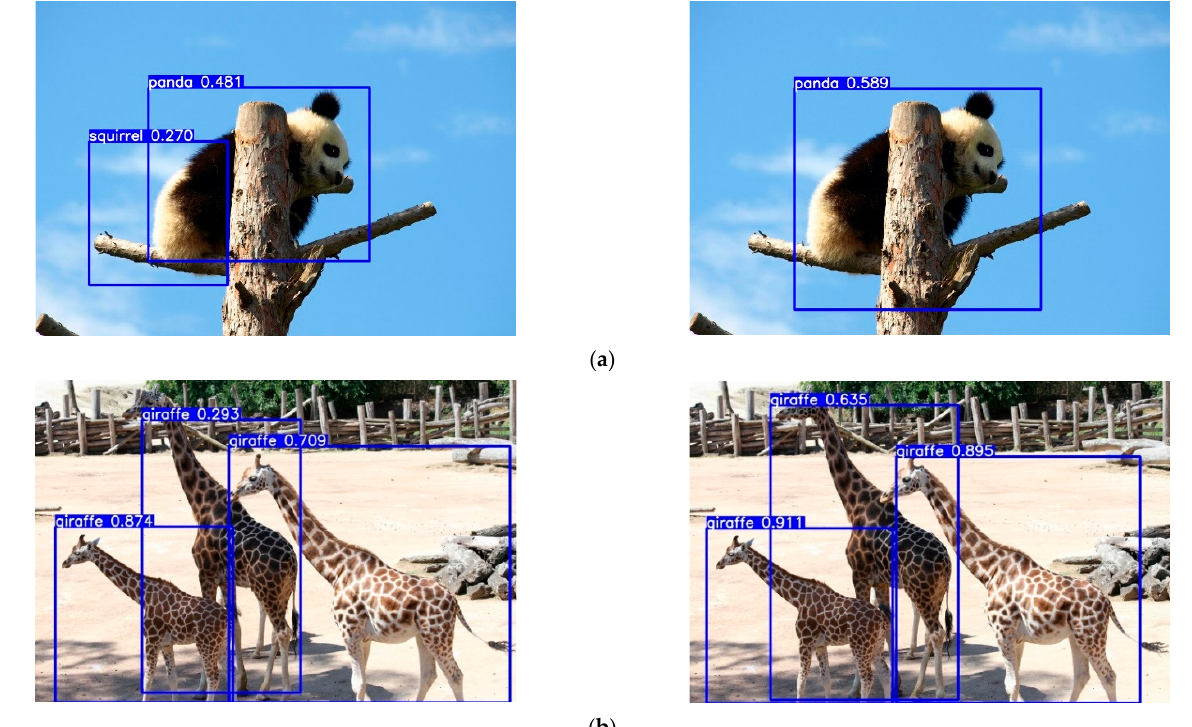
Figure 12. ( a ) Detection results in the panda before and after improvement; ( b ) detection results in giraffes before and after improvement.